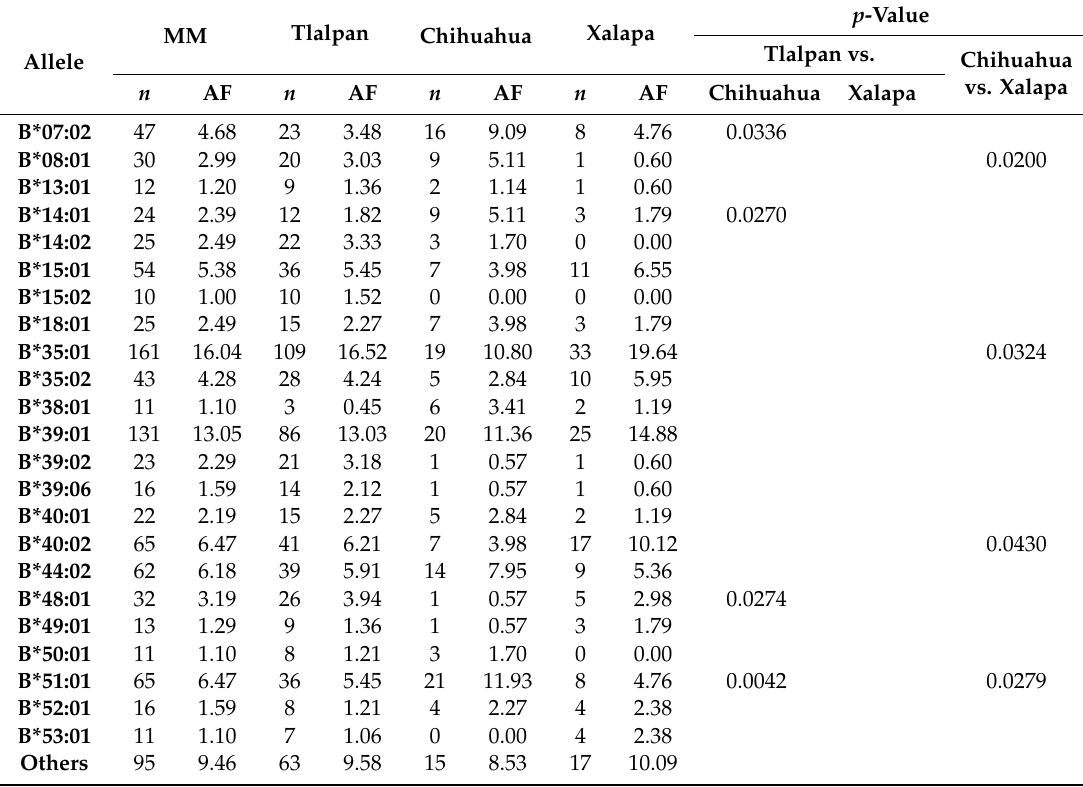
Table 3. HLA-B allele frequency from Mexico: Tlalpan, Chihuahua, and